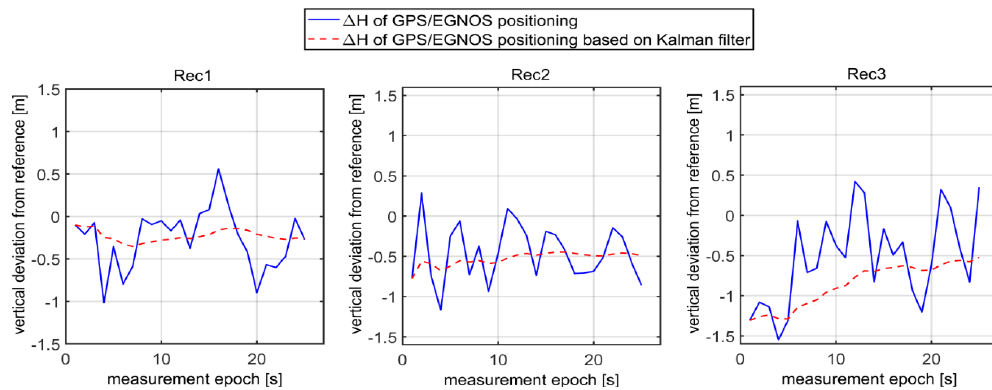
Figure 5. Accuracy of the vertical coordinate of EGNOS positioning for three mobile receivers in initial measurement time span together with Kalman filtering.